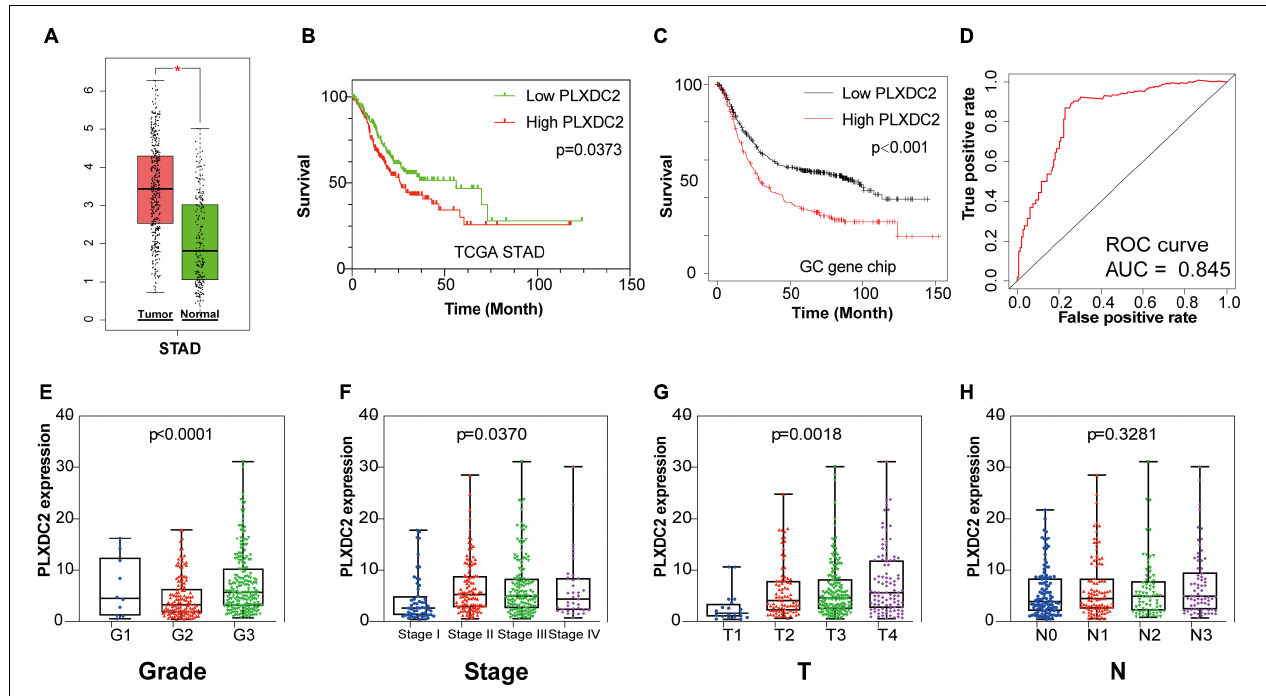
FIGURE 3 | PLXDC2 is a DEG capable of propelling GC progress. (A) Differential expression of PLXDC2 in normal and tumor samples generated by GEPIA2. Analyses were performed across normal and tumor samples of TCGA STAD alongside GTEx normal samples. (B) Survival analysis of TCGA STAD patients with different PLXDC2 expression levels. Patients were sorted into high expression or low expression groups according to the median expression level ( p = 0.0373 by log-rank test). (C) Survival curves of GC patients generated by Kaplan–Meier Plotter ( p < 0.0001 by log-rank test). (D) ROC curve for PLXDC2. An AUC close to 1 suggests high reliability. (E–H) The relationship between PLXDC2 expression and tumor grade, clinical stage, T stage and N stage. Each dot signifies the PLXDC2 expression level in a sample.